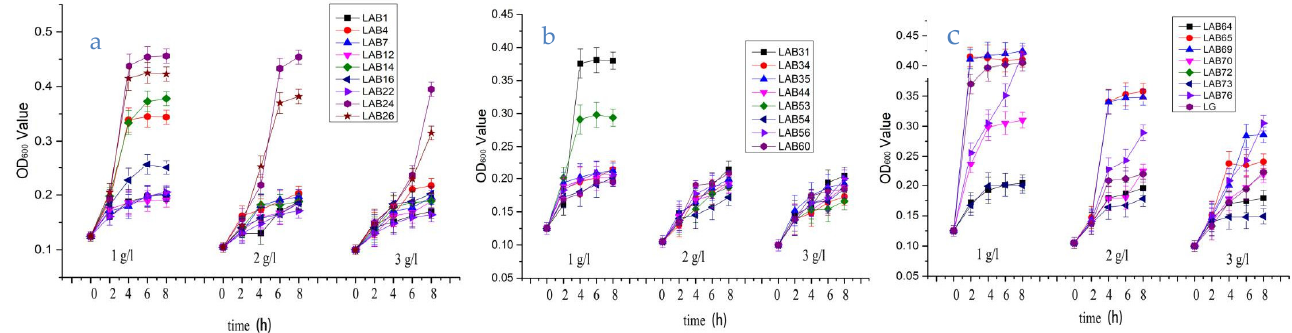
Figure 2. The bile salt tolerance of 24 strains of Lactobacillus . Note: ( a )-The growth of 8 strains of Lactobacillus ( LAB1, LAB4, LAB7, LAB12, LAB14, LAB16, LAB22, LAB24) under the condition of 1 g/L, 2 g/L, 3 g/L bile salt concentration for 8 h; ( b )-The growth of 9 strains of Lactobacillus ( LAB26, LAB31, LAB34, LAB35, LAB44, LAB53, LAB54, LAB56,LAB60) under the condition of 1 g/L, 2 g/L, 3 g/L bile salt concentration for 8 h; ( c )-The growth of 8 strains of Lactobacillus ( LAB64, LAB65, LAB69, LAB70, LAB72, LAB73, LAB76, LG) under the condition of 1 g/L, 2 g/L, 3 g/L bile salt concentration for 8 h.